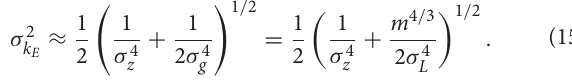
FIGURE 4 | Example electron beam phase space distribution (from FERMI [Allaria, personal communication]) with dominant quadratic structure and higher order structure near the head and tail. The optimized laser pulse length to produce a minimum bandwidth depends on the amplitude of the non-linearities in the